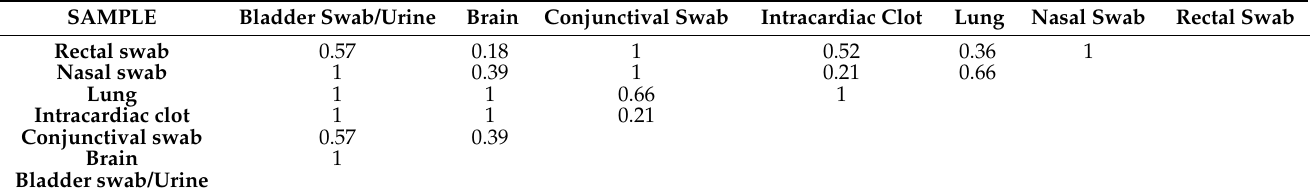
Table 4. Values obtained for the comparison of the positivity of the biological samples with the Fisher’s test ( p -value < 0.05). SAMPLE Bladder Swab/Urine Brain Conjunctival Swab Rectal